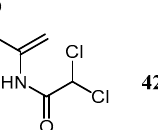
Figure 5. Structure of α -dichloroacetamido- p